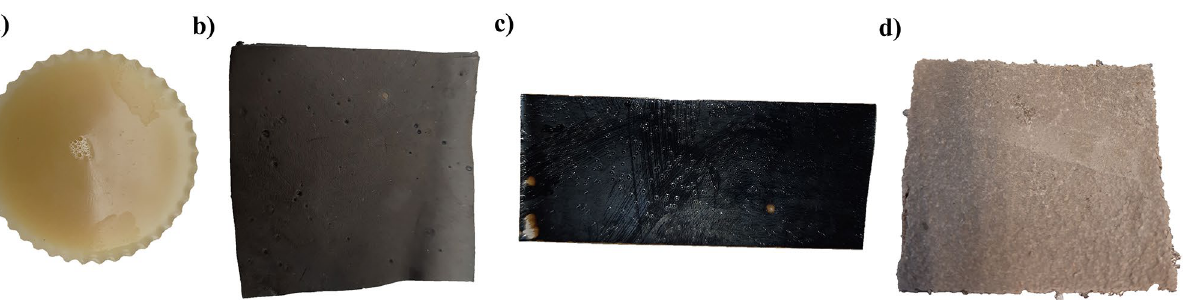
Figure 6. Coating materials samples. ( a ) EP ( b ) BW ( c ) BR ( d )